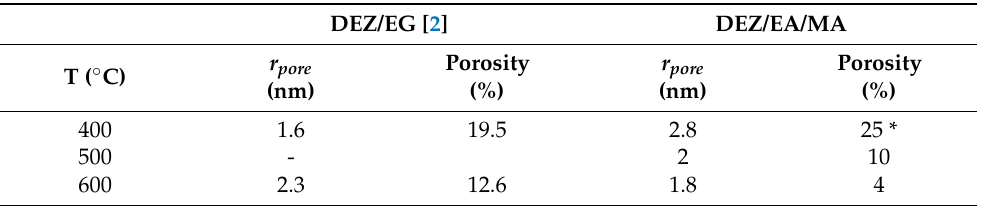
Table 2. Porosity and average pore radii of calcinated ZnO thin films obtained from DEZ/EG 2 - and DEZ/EA/MA-cycle MLD for different heating temperatures.* This value is estimated.